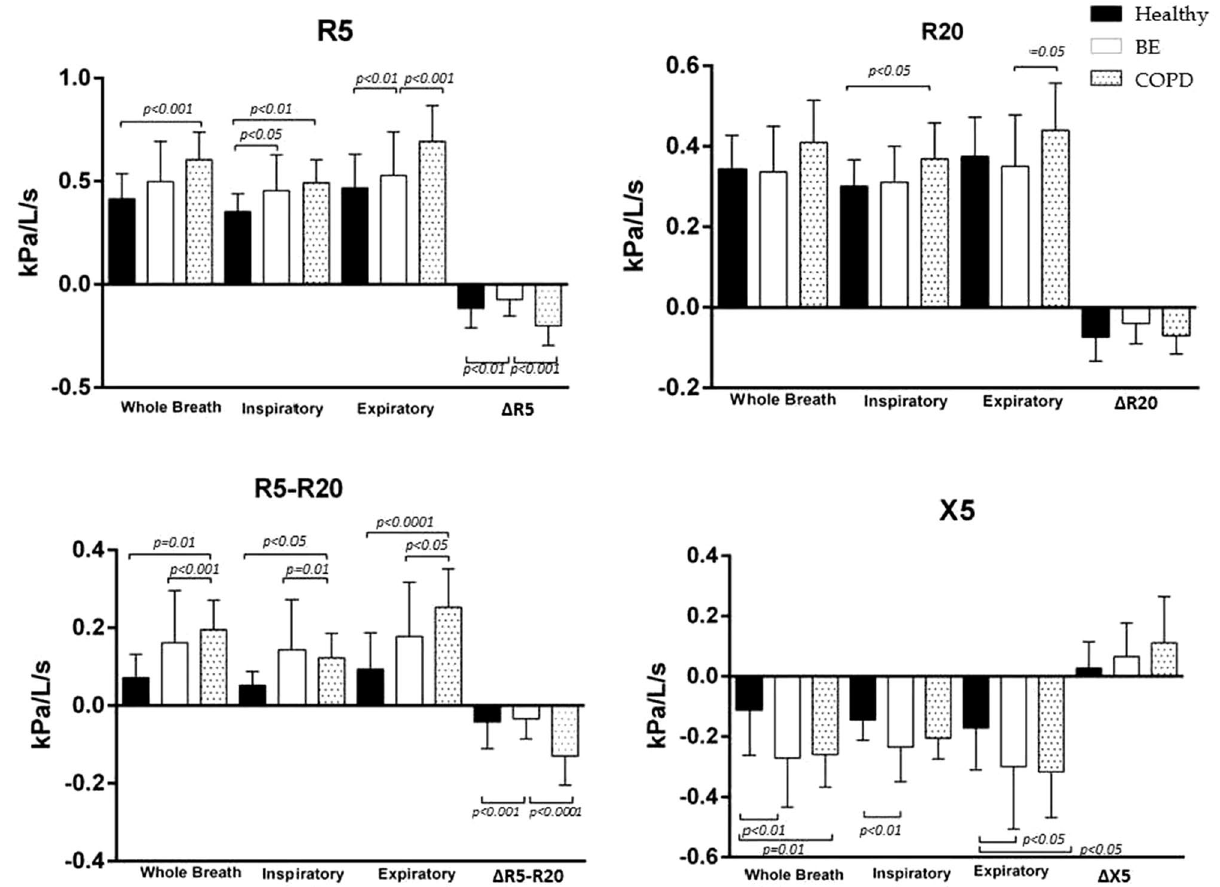
Figure 1. Comparison of resistance at 5 Hz (R5), R20, R5-R20 and reactance at 5 Hz (X5) in whole-breath, inspiratory and expiratory phases and difference inspiratory–expiratory (Δ), in healthy subjects (back bars), patients with bronchiectasis (BE) (white bars) and chronic obstructive pulmonary disease (COPD) (dotted bar).